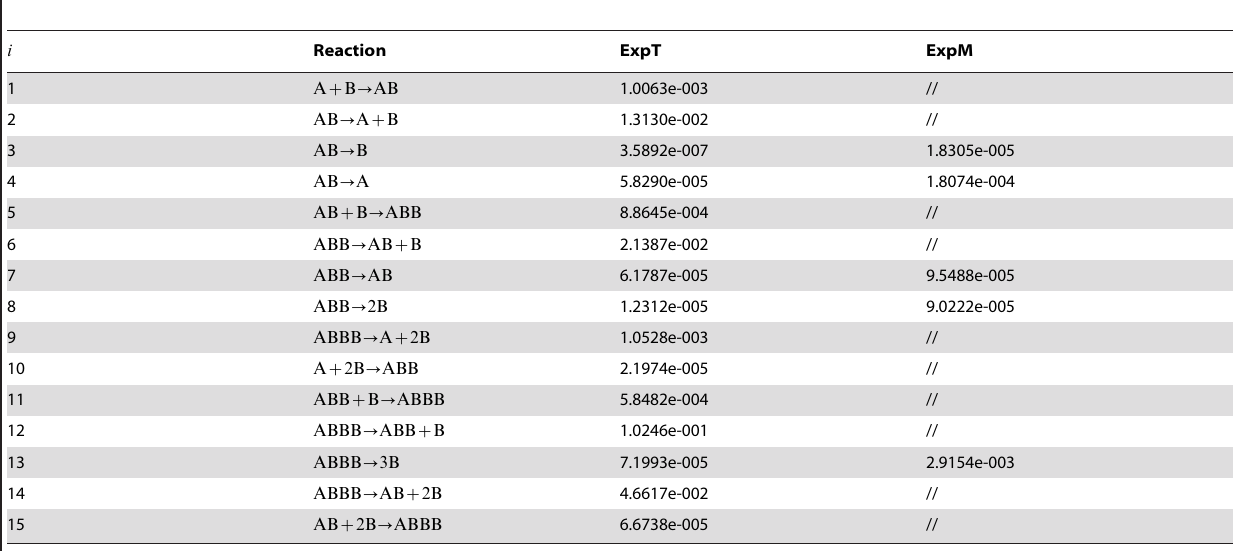
Table 5. Values of estimated reaction constants ( k i ) obtained using different sets of